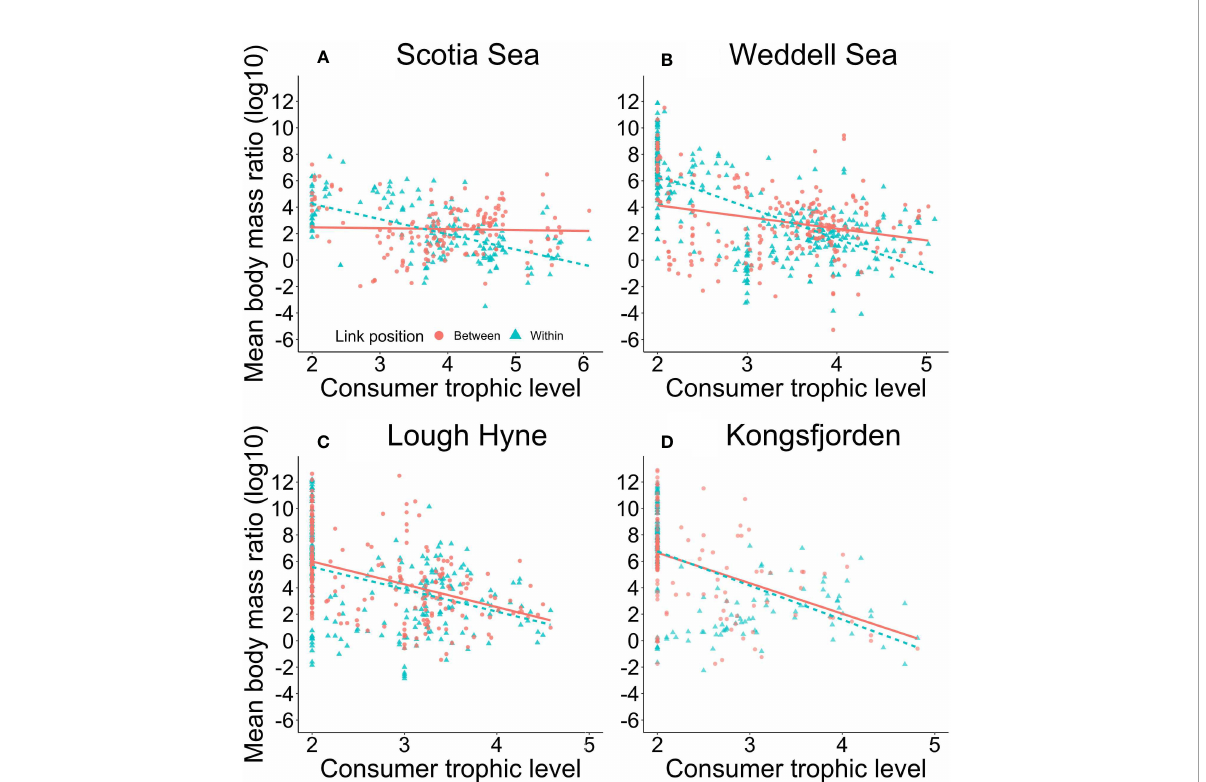
FIGURE 7 Average body mass ratio of every consumer to each of its resources, plotted against the trophic level of the consumer, for each network: (A) Scotia Sea; (B) Weddell Sea; (C) Lough Hyne; (D) Kongsfjorden. Point shape and colour indicate whether the focal interaction occurred among species within the same module, or between modules. There was an interactive effect of consumer trophic level and link position on consumer-resource body mass ratio for the Scotia Sea (within: y = 6.62 – 1.17x, p< 0.001, r2 = 0.35; between: y = 2.48 – 0.04x, p = 0.807, r2 = 0.01) and Weddell Sea (within: y = 11.77 – 2.59x, p< 0.001, r2 = 0.50; between: y = 5.27 – 0.70x, p< 0.001, r2 = 0.10). There was only a signi fi cant main effect of consumer trophic level on consumer-resource body mass ratio for Lough Hyne (y = 9.22 – 1.71x, p< 0.001, r2 = 0. 20) and Kongsfjorden (y = 11.64 – 2.47x, p< 0.001, r2 =